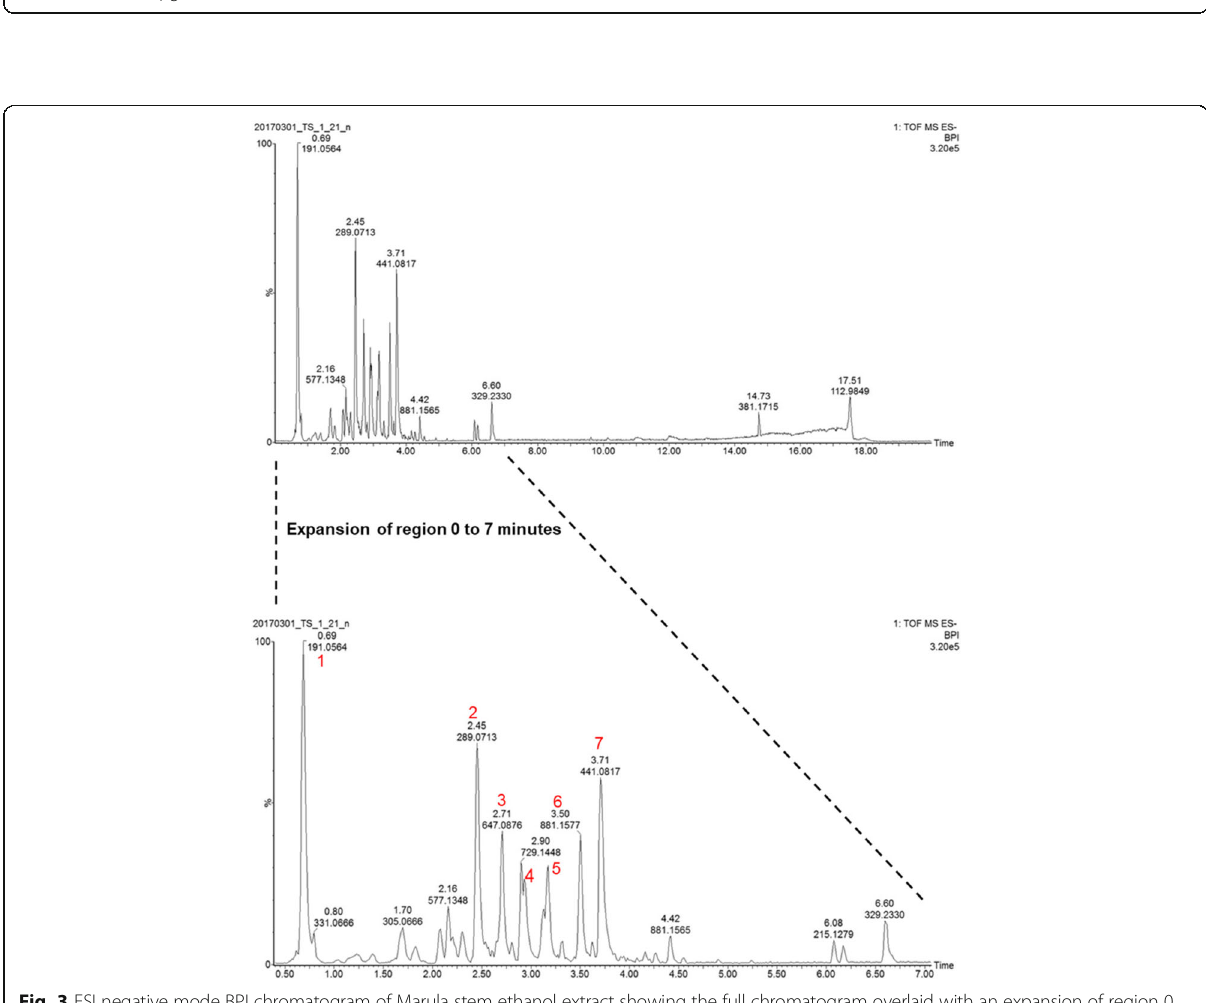
Fig. 3 ESI negative mode BPI chromatogram of Marula stem ethanol extract showing the full chromatogram overlaid with an expansion of region 0 to 7 min. A total of six compounds were identified, the presence of four of these; quinic acid (peak 1), catechin (peak 2),epigallocatechin-3-gallate (peak 4), and epicatechin gallate (peak 7) was confirmed using pure standards on UPLC-QTOF-MS. Epicatechin-3-O-gallate-epicatechin (peak 5) and procyanidin B2-3 ′ 3 di-O-gallate (peak 6) were tentatively identified and peak 3 was